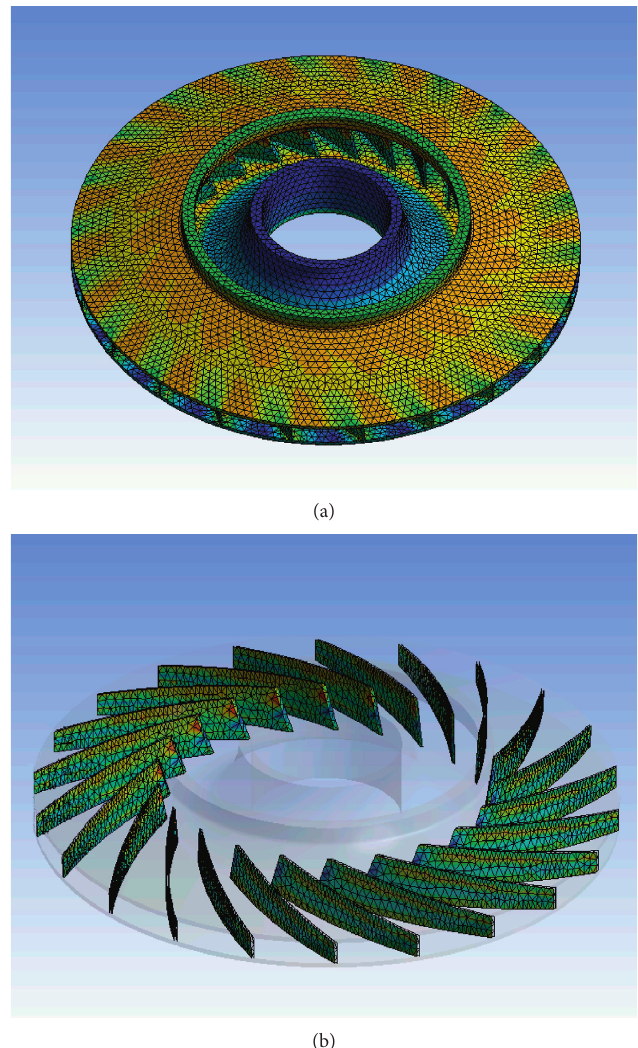
Figure 3: (a) The stress distribution of the No. 0 impeller and (b) its